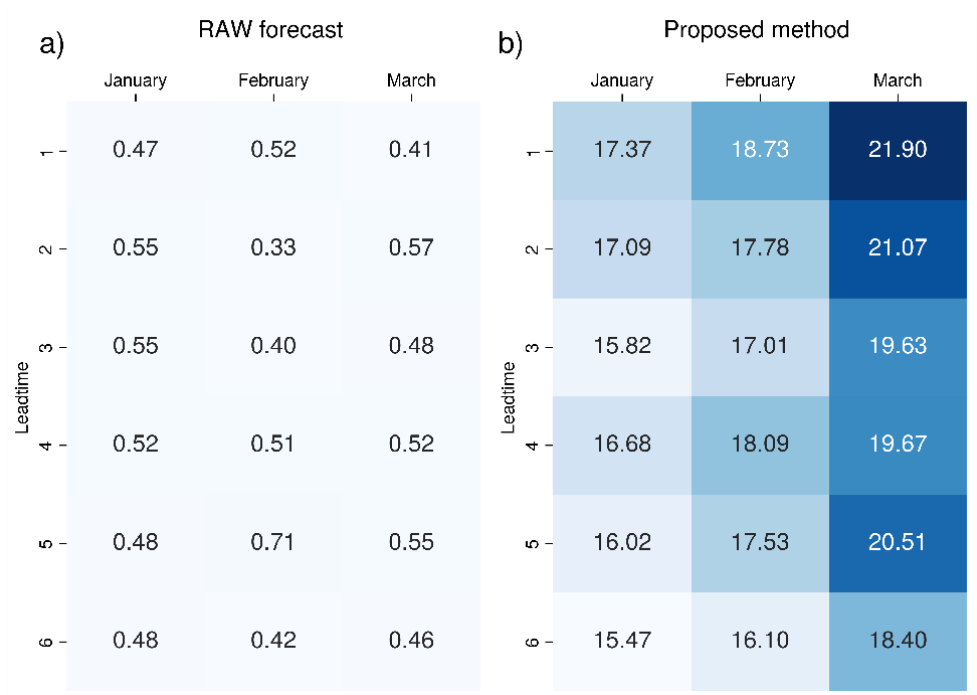
Figure 11. Mean percentage of ensemble members correctly predicting 2 m mean temperature over the 99th percentile value for seasonal forecast SEAS5 (ECMWF): ( a ) raw data and ( b ) data corrected with the proposed bias correction method. The colour scale ranges from white (0%) to dark blue, increasing in intensity as the percentage increases. The most intense colour corresponds to the maximum value (in this case, 21.9% for March and lead time one).